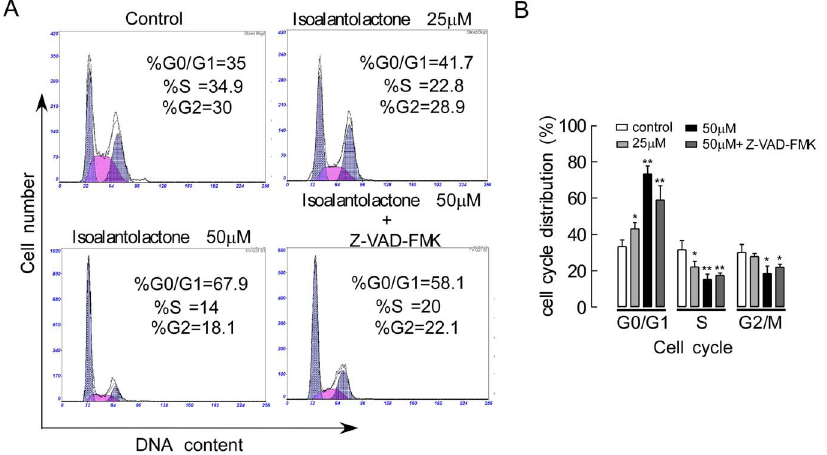
Figure 3. The effect of isoalantolactone on the cell cycle in UM-SCC-10A cells. (A) The DNA content in each cell cycle phase in UM-SCC-10A cells was analyzed by flow cytometry. The representative histograms are from UM-SCC-10A cells incubated with different concentration of isoalantolactone (25 and 50 m M) or caspase inhibitor (Z-VAD-FMK50 m M). (B) Isoalantolactone treatment induced a dose-dependent increase in the proportion of cells in the G1 phase and a decrease in cells in the S and G2 phases compared to the control. Z-VAD-FMK treatment did not prevent cell cycle arrest following high-dose isoalantolactone treatment. The results are represented as the mean 6 SEM for three independent experiments with similar results. * P , 0.05 and ** P , 0.01 compared to the control.